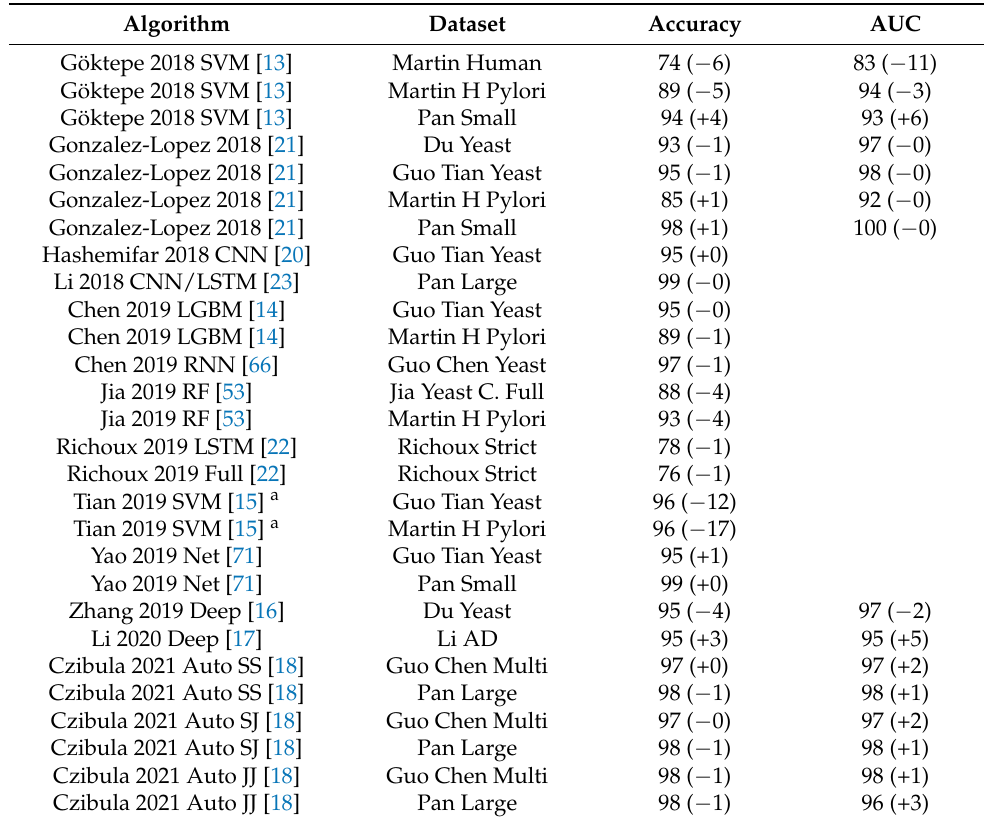
Table 5. Comparisons of the range of values per dataset in previous literature and our